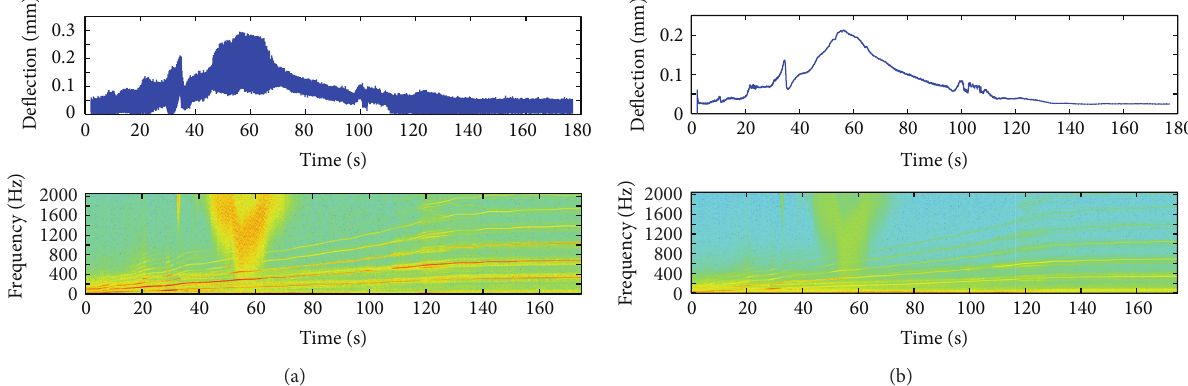
Figure 10: An initial run-up current characteristic (node 5) for the run-up case by STFT (a) in former filtering and (b) after filtering.